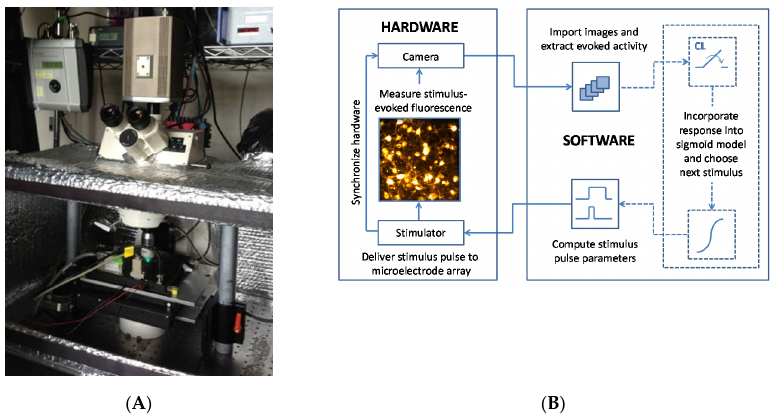
Figure 1. The closed ‐ loop system of electrical stimulation, optical recording, automated image analysis and activation curve modeling. ( A ) A photograph of the system apparatus is shown. The camera is mounted atop the microscope with an inline piezoelectric actuator connected to the 20× objective for high ‐ precision focal plane adjustments. LED fluorescence excitation is digitally controlled using the TLC001 current controller eliminating the need for a shutter. The neuronal culture lives atop the microelectrode array (MEA), which is nested inside of the heated Multi Channel Systems preamplifier. Imaging is carried out inside of an enclosure to eliminate ambient light exposure and reduce the effects of other environmental factors including the laboratory heating and ventilation. The preamplifier is housed inside of this “light tight” imaging chamber and interfaces with the external stimulator. ( B ) Hardware for delivering electrical stimuli and for optically recording evoked responses